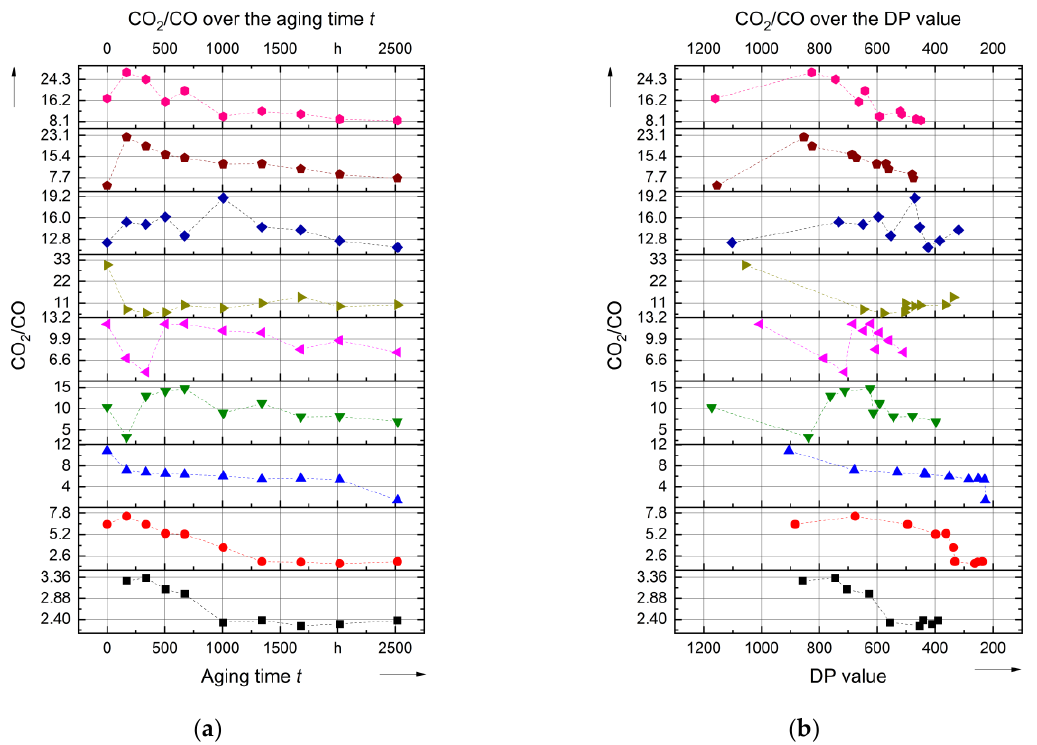
Figure 9. Change of CO 2 /CO ratio for the different sealing systems and fluids: ( a ) Change over the aging time; ( b ) Change over the DP value; the legends refer to Figure 6a.